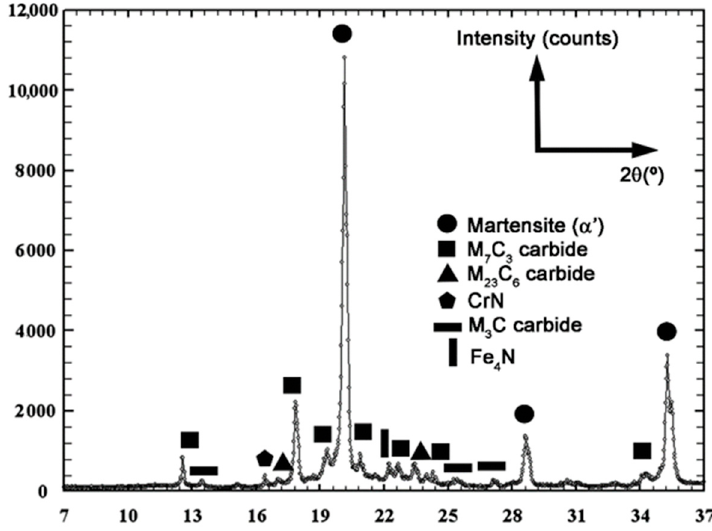
Figure 6. Diffractogram of the nitrided surface of sample corresponding to experiment 8.